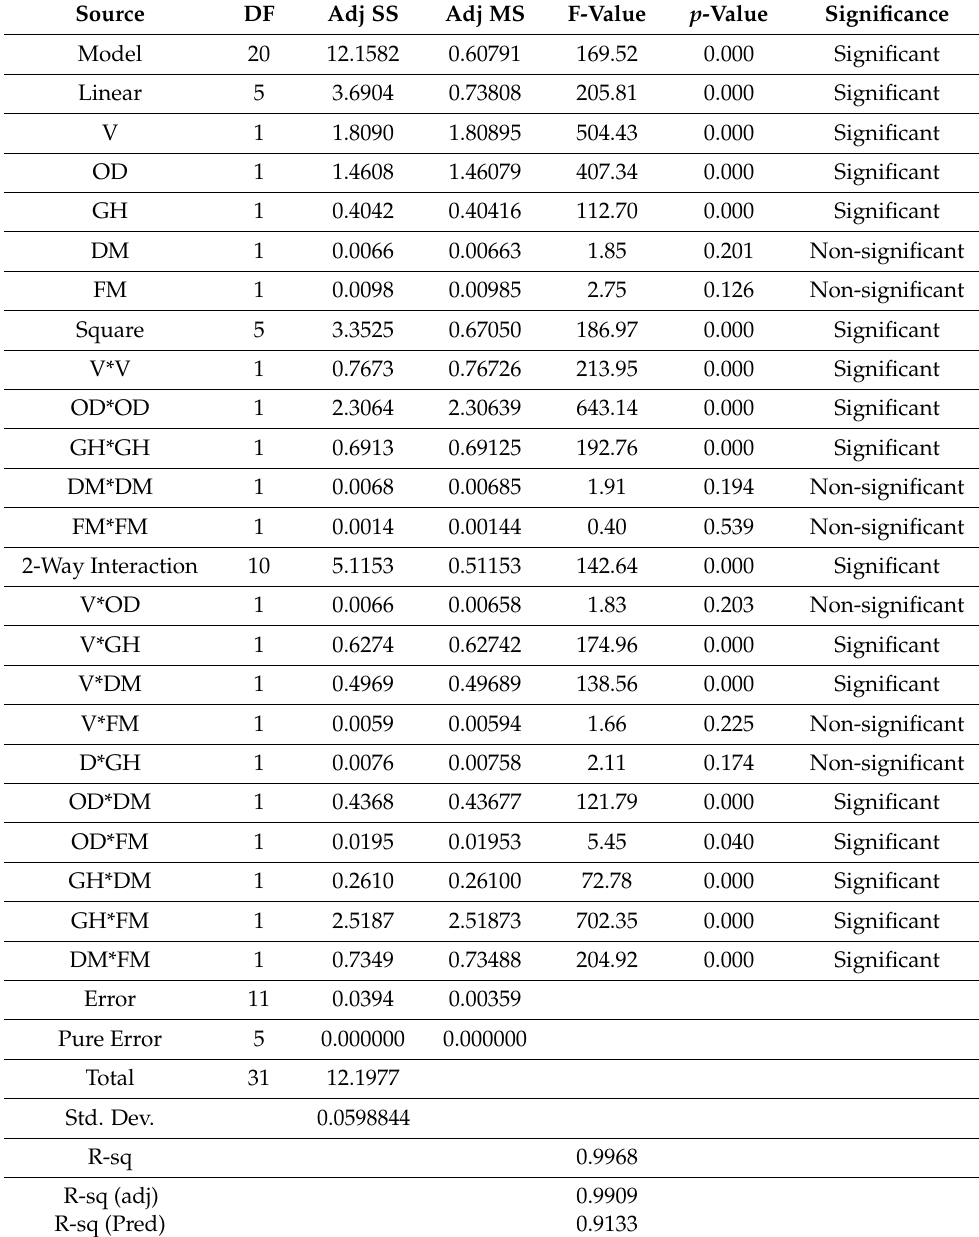
Table 3. ANOVA analysis for average middle particle mass